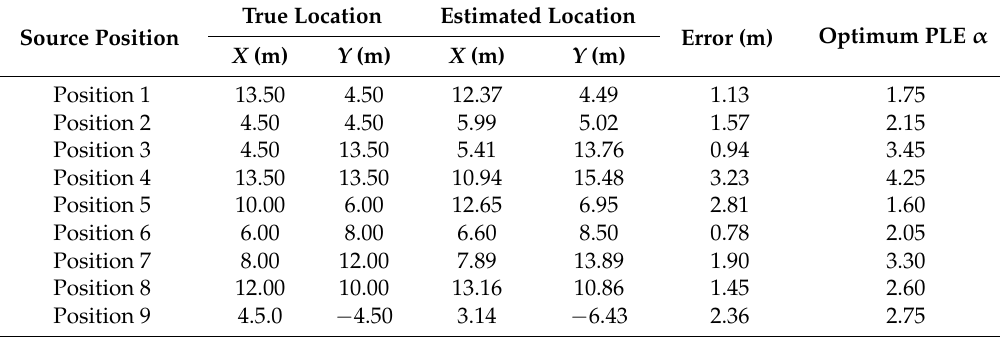
Table 2. PD source location estimation with seven sensors used, proposed method.